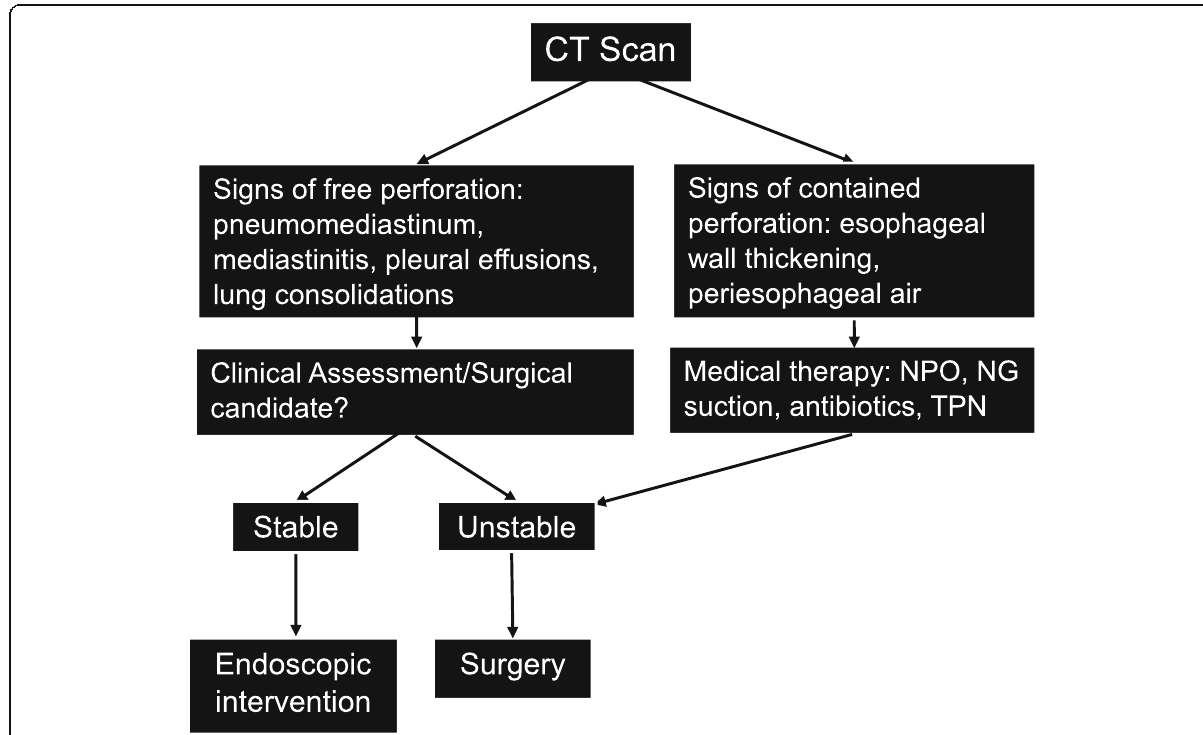
Fig. 1 Clinical consideration for esophageal perforation. Note. NPO = nothing by mouth, NG = nasogastric, TPN = total parenteral